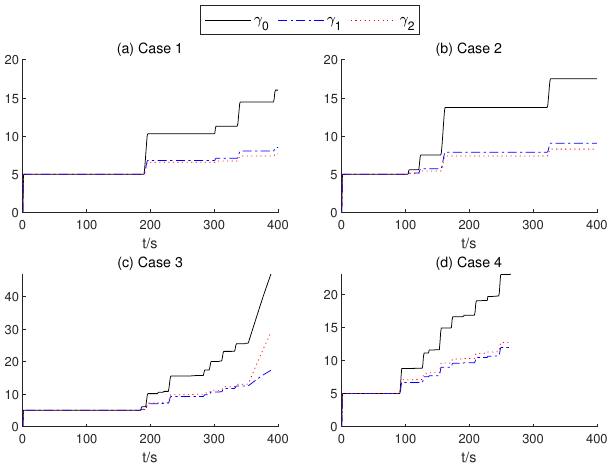
Figure 14. θ 2 of the mean part of the TSMC Net.